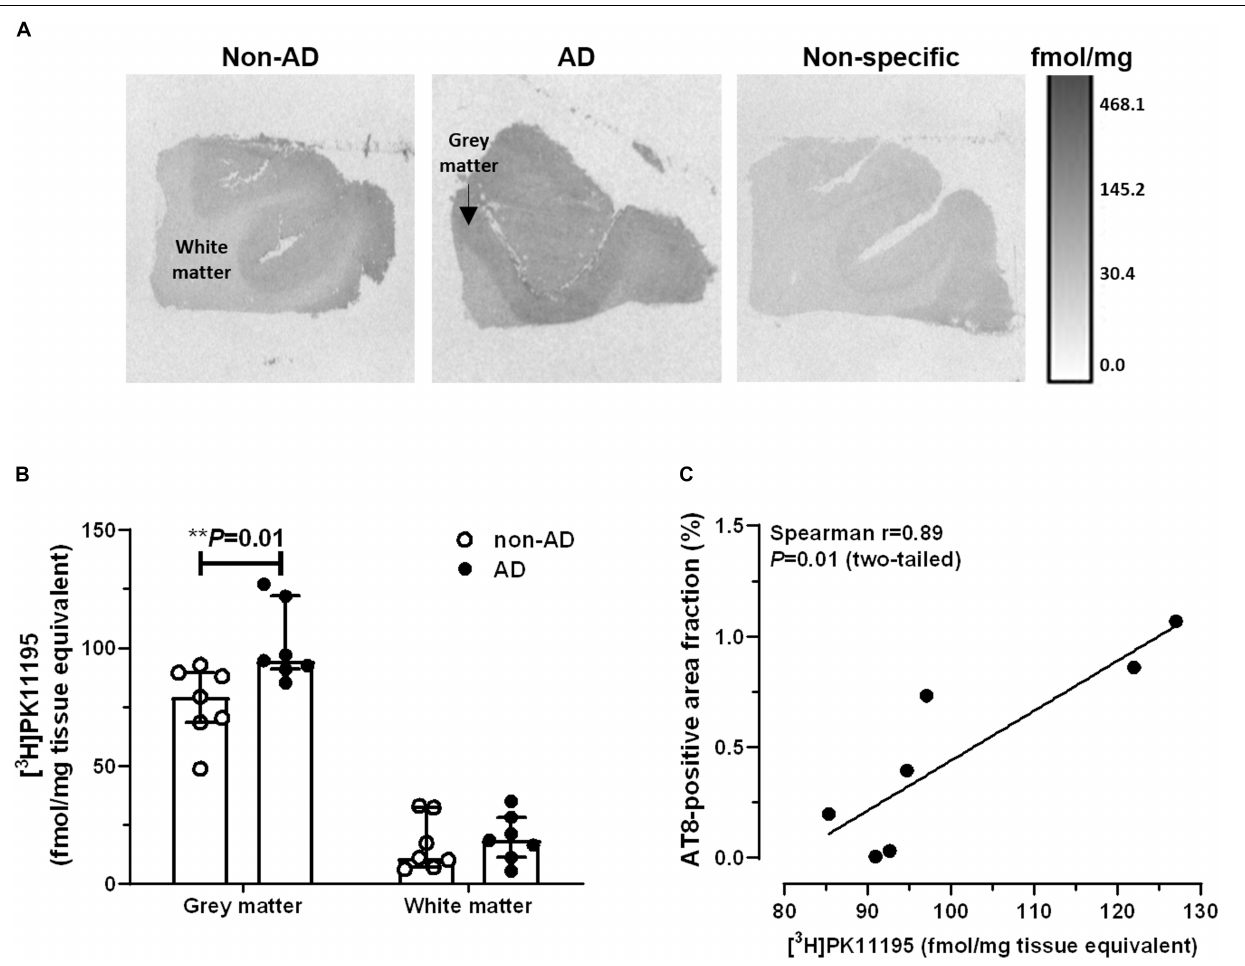
FIGURE 2 | Autoradiography of [ 3 H]PK11195 binding sites. (A) Representative autoradiograms of TSPO binding sites in the middle frontal gyrus of non-demented subjects and AD patients. The scale bar represents an interpretation of black and white image density, calibrated in fmol/mg of tissue equivalent. (B) Increased binding levels were observed in the gray matter of AD patients, compared to non-AD subjects ( ∗∗ P = 0.01, Mann-Whitney U tests, two-tailed). (C) In AD patients, levels of [ 3 H]PK11195 binding were positively correlated with pTau immunoreactivity. Results are presented as the median and interquartile range of n = 7